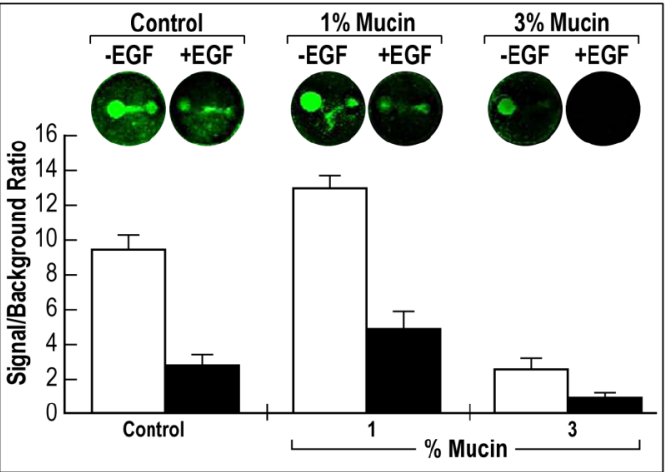
Figure 5. NIR bio-imaging of EGFR levels in focal cultures of A431/COLO205/IEC6 cells. 10 nM EGF-NIR was incubated for 15 min at 37 °C with the cultures pretreated with either 1% or 3% mucin, in the presence of 100 nM unlabeled EGF (+EGF) or in its absence ( − EGF). SBR of specific binding was calculated for A431/IEC6 (white bars) and for COLO205/IEC6 (black bars). The upper inserts represent the cultures at the end of the experiment. Left focus—A431 cells; Right focus—COLO205 cells; NIR imaging was estimated (mean ± SD, n = 3) at the following conditions: resolution: 170–340 microns; pixel area: 0.03 mm 2 ; quality: medium-low; focus offset: 3; channels: 800 nm; intensity: 1; * p < 0.05 vs. scrambled or